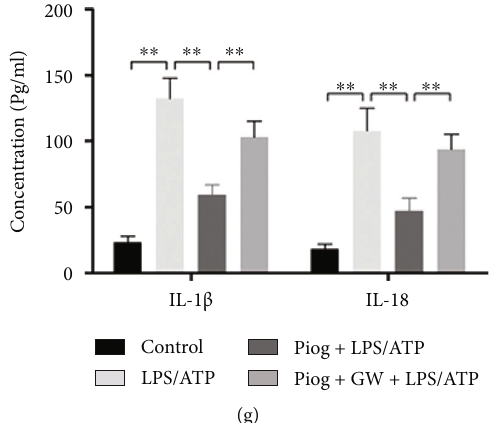
Figure 3: Piog attenuates LPS/ATP-induced pyroptosis of chondrocytes. (a) MTS assays were performed for cell toxicity after Piog treatment for 24 hours. (b and c) MTS and CCK8 assays were performed for rat chondrocyte viability. Piog pretreatment for 2 hours before LPS treatment for 24 hours and subsequent stimulation with ATP for 30 minutes. (d) CCK8 assays were performed for the e ff ect of Piog on LPS/ATP-treated chondrocyte viability after GW antagonizing PPAR- γ using 20 μ M Piog, 1 μ M LPS, 5 mM ATP, and 10 μ M GW. (e and f) Western blot and densitometric analysis of the immunoblots for NLRP3, caspase-1 P10, and GSDMD-N in the control, LPS/ATP, Piog+ LPS/ATP, and GW +Piog+ LPS/ATP groups. GAPDH was used as an internal reference. (g) ELISA was performed for IL-1 β and IL-18 concentrations in the control, LPS/ATP, Piog+LPS/ATP, and Piog+GW +LPS/ATP groups. The data represent three independent experiments and are expressed as mean ± SD. * P < 0 : 05 and ** P < 0 : 01